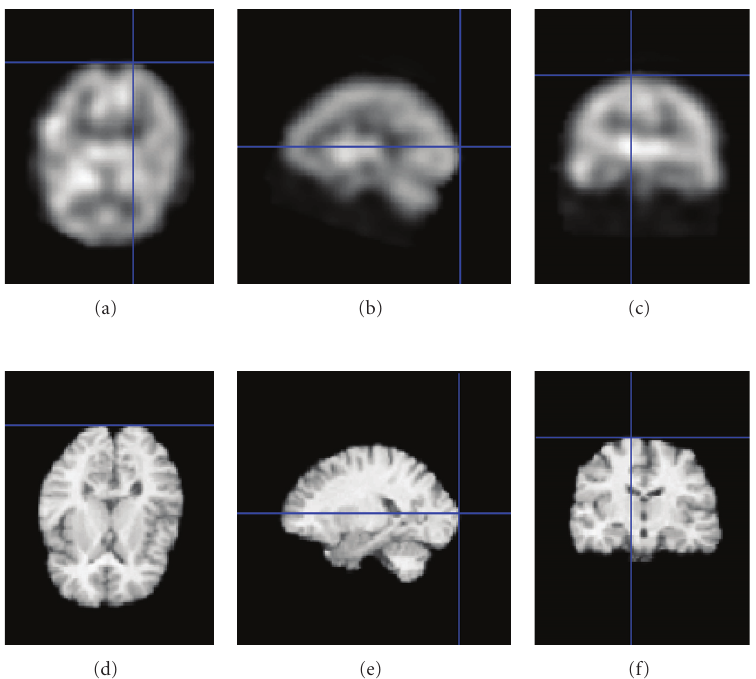
Figure 7: Examples of registration of the MR volume to the SPECT volume (using registration method described in Section 3.1). (a), (b), (c): Axial, sagittal, and coronal view of a SPECT volume. (d), (e), (f): Axial, sagittal, and coronal view of a registered MR